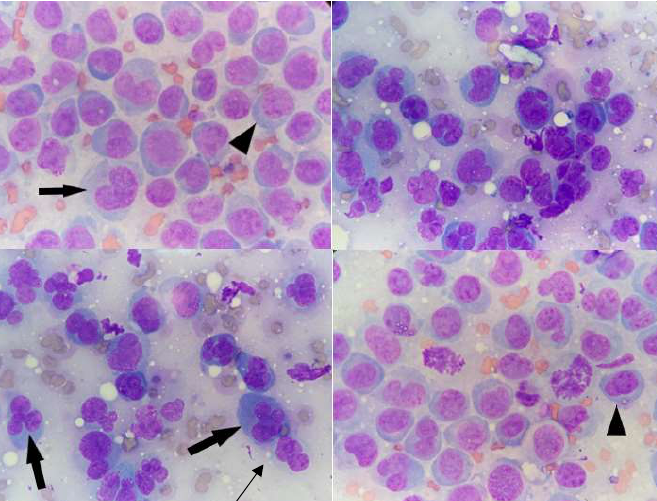
Figure 2. Fine needle aspiration cytology of skin nodules in a 12-year-old non-neutered male Beagle with cutaneous non epitheliotropic B-cell lymphoma (CNEBL) with plasmablastic differentiation versus multiple cutaneous plasmacytosis (CP). Note the evidence of monomorphic round cell pop- ulations of medium-large cells with multi-lobed flower-like nuclei (black arrows), reticular chroma- tin, and occasionally evident multiple nucleoli (arrowheads). These cells had scant to moderate ba- sophilic to clear cytoplasm containing occasional punctate clear vacuoles (Diff-Quick, 100×). 4. Histopathology Skin biopsies from a subcutaneous mobile nodule of the right inguinal region (1 × 1 × 0.5 cm 3 ) (Figure 3a), a non-mobile nodule of the rump region (0.7 × 0.7 × 0.4 cm 3 ) and a non-mobile nodule of the proximal region of the left paw (0.8 cm diameter punch) (Figure 3b) were examined. All the samples examined showed the presence of a densely cellular, poorly demarcated, non-encapsulated and infiltrative growing tumor. The tumor ex- panded, in one of the nodules, the thickness of the middle and deep dermis, while in the other two nodules, it extensively involved the adipose panniculus subcutaneous. The ne- oplasm consisted of densely packed parallel sheets of round cells with mostly distinct cy- toplasmic borders, moderate amounts of weakly eosinophilic or pale and occasionally vacuolized cytoplasm, large, round, or frequently indented, central nuclei (3–4 red blood cells in size) with vesicular chromatin and sometimes prominent and multiple nucleoli (Figure 3c). Moderate anisocytosis and anisokaryosis were visible, and mitotic count was 35 mitosis/10 HPF (2.37 mm 2 ). Single cell necrosis and small disseminated necrotic foci were observed in association with small hemorrhages. Epitheliotropism of neoplastic cells into the epidermis or adnexal structures was not evident. Giemsa staining of neoplastic cells was negative (Figure 3d). Based on histological examination, a diagnosis of B-cell lymphoma vs. cutaneous plasmacitosis was obtained.